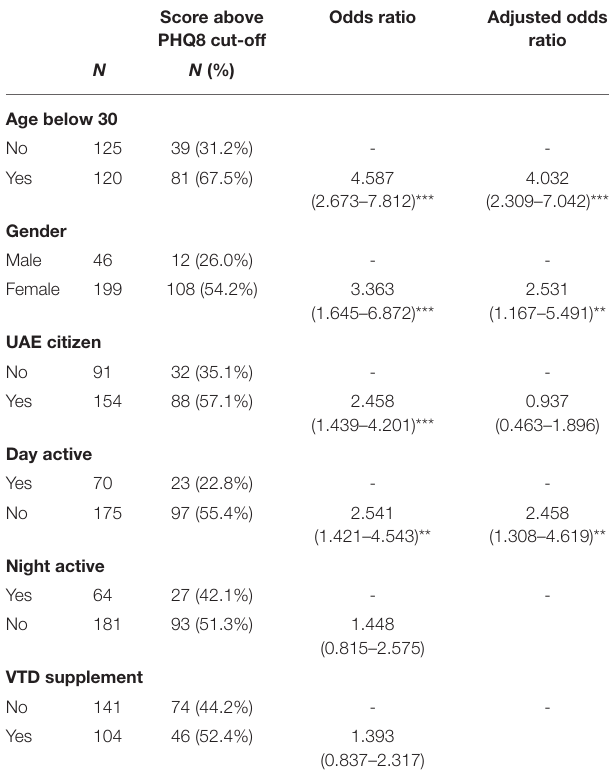
TABLE 1 | Means and standard deviations for endorsement of outdoor activities. Outdoor activities